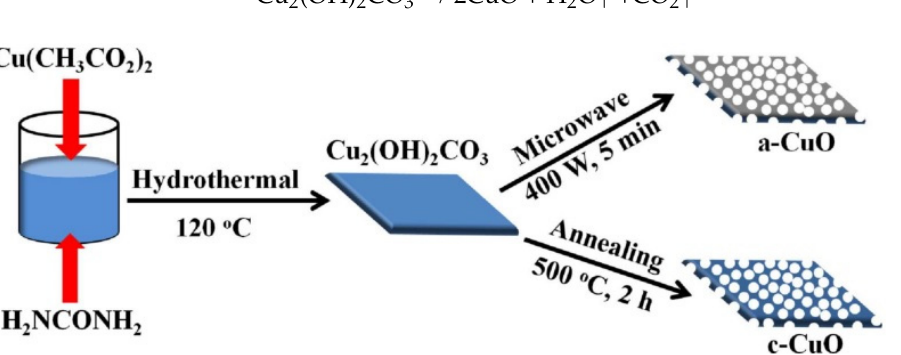
Figure 8. The designed synthetic route of the c-CuO and a-CuO porous nanosheets. Reprinted from Tian et al. [78]. Published 2020 by Wiley as open access.